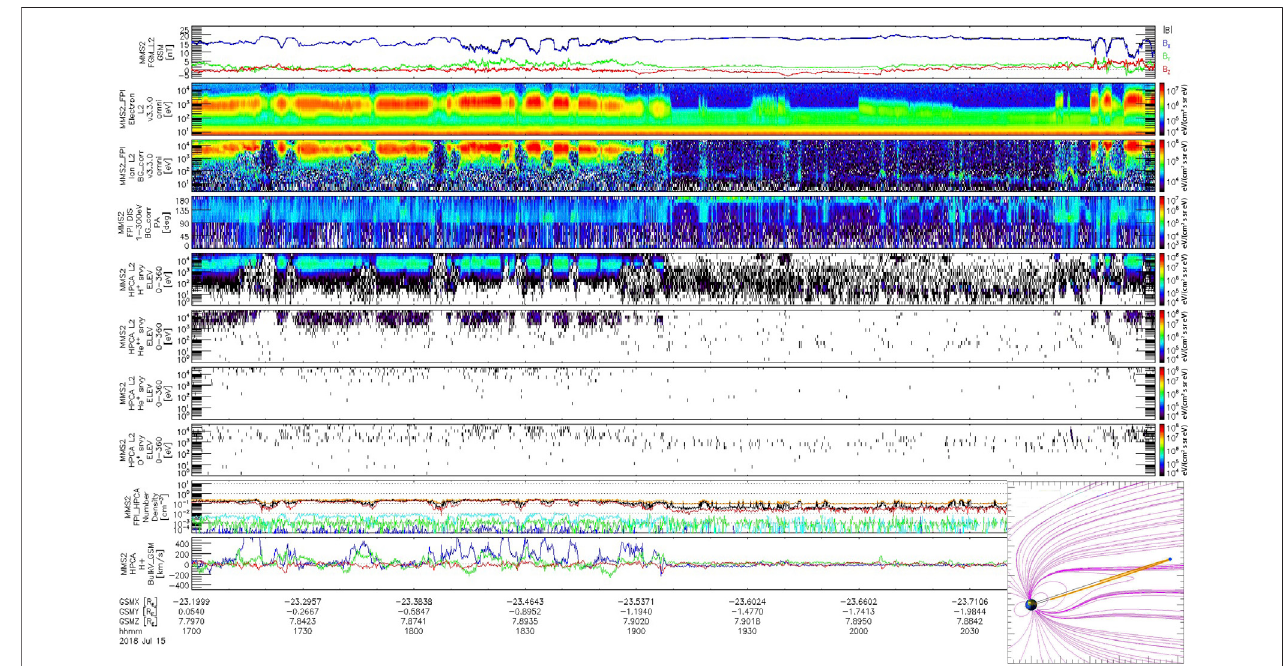
FIGURE 14 | A composite picture of MMS data on July 15, 2018 through the plasma sheet boundary layer at the interface of the lobe and plasma sheet.